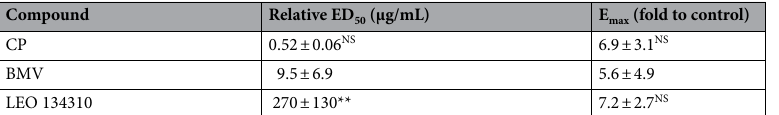
Table 4. Pharmacological activity of LEO 134310A vs CP and BMV in human skin assessed by gene expression levels of FKBP5 . Effective doses (API concentrations in dosing solution) of CP (n = 6 studies), BMV (n = 3 studies) and LEO 134310A (n = 5 studies) to induce FKBP5 levels to 50% of maximum response (ED 50 ). FKBP5 levels were normalised to vehicle-treated controls and E max and ED 50 were estimated in a sigmoid E max model. Weighted geometric mean ± standard deviation. Statistical comparison (T-test) against BMV ( NS not